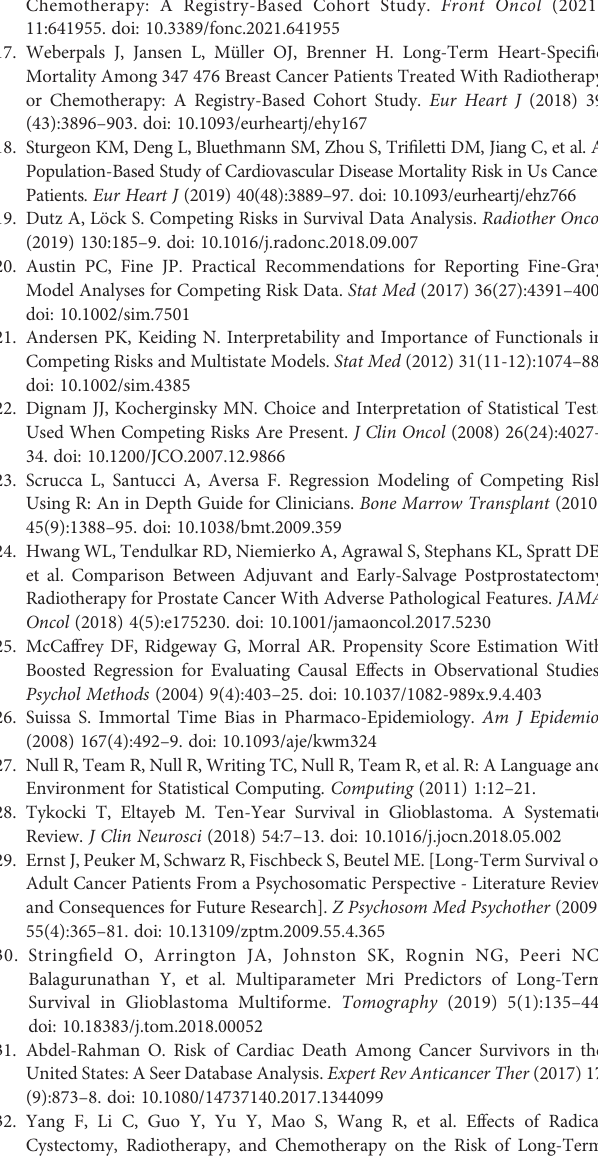
Supplementary Figure 1 | Heart disease speci fi c survival curves of anaplastic astrocytoma patients strati fi ed according to (A) sex, (B) race, (C) tumor size, (D) sequence number based on Kaplan-Meier method. Supplementary Figure 2 | Cumulative incidence plots based on competing risk regression model of anaplastic astrocytoma patients strati fi ed according to (A) Sex, (B) race, (C) marital status, (D) the year of diagnosis, (E) primary site, (F) tumor size, (G) surgery, (H) surgery method, (I) radiation and (J) sequence number. Supplementary Figure 3 | Heart disease speci fi c survival curves of anaplastic astrocytoma patients in PSM-after cohort strati fi ed according to (A) sex, (B) race, (C) marital status, (D) the year of diagnosis, (E) tumor size, (F) surgery, (G) surgery method, (H) radiation and (I) sequence number based on Kaplan-Meier